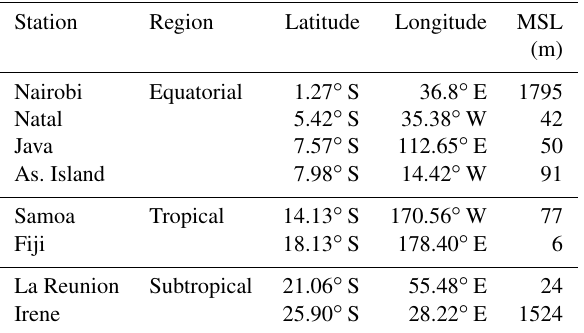
Table 1. Geolocation and mean sea level (MSL) of stations investi- gated in this